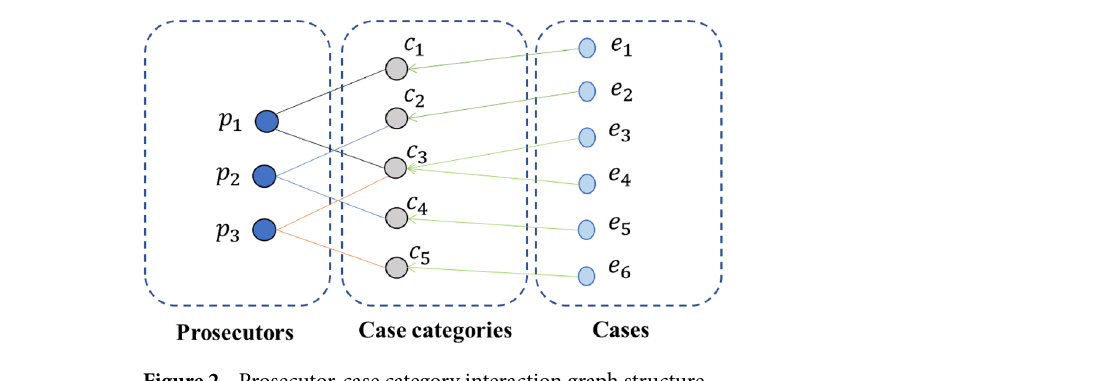
Figure 2. Prosecutor-case category interaction graph